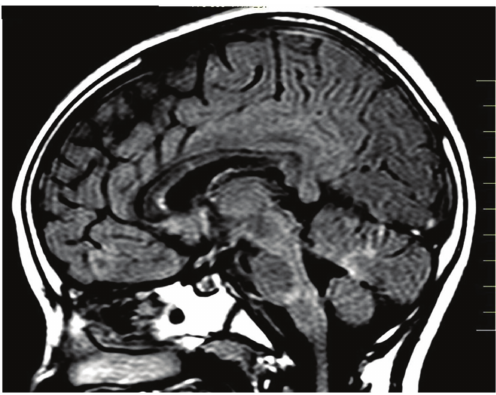
Figure 3: Brain MRI showing multiple infratentorial lesions.